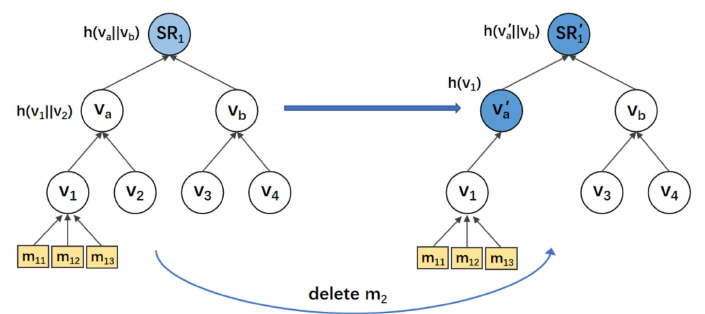
Figure 7. The process of deleting the data block m 2